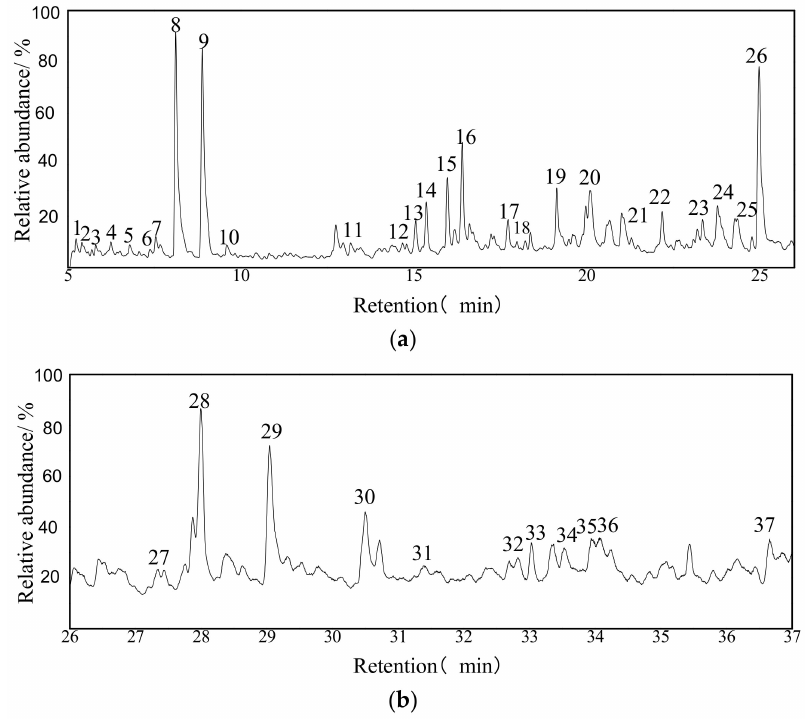
Figure 4. TIC of the extract by use of UAE. ( a ) TIC of 5–26 min; ( b ) TIC of 26–37 min. Table 2. Organic substances identified in the extracts from the coal samples with di ff erent extraction